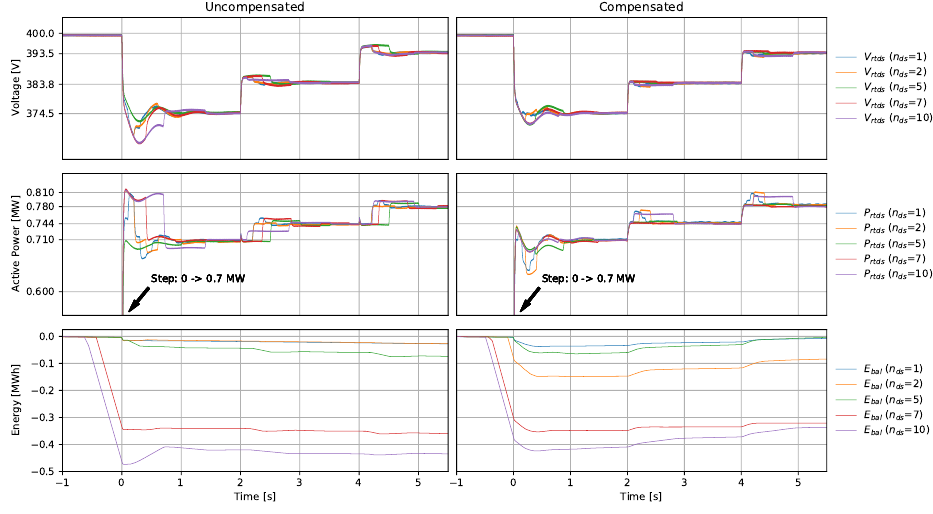
Figure 15. Voltage response of DL step at PHiL interface with varying sampling rates.